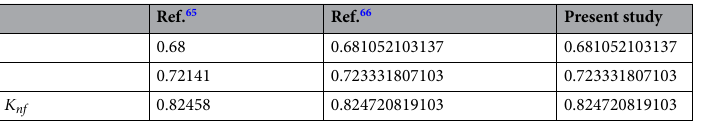
Table 4. In the case of nanofluids, the temperature changes were compared to the reported data of Ref. 65 and Ref. 66 .